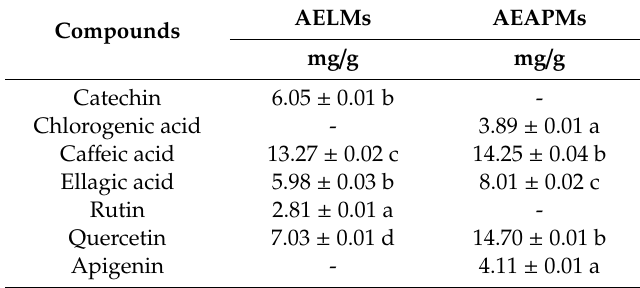
Results are the mean ± standard deviation (SD) from three determinations. Averages followed by different letters differ by Tukey’s test at p < 0.05.